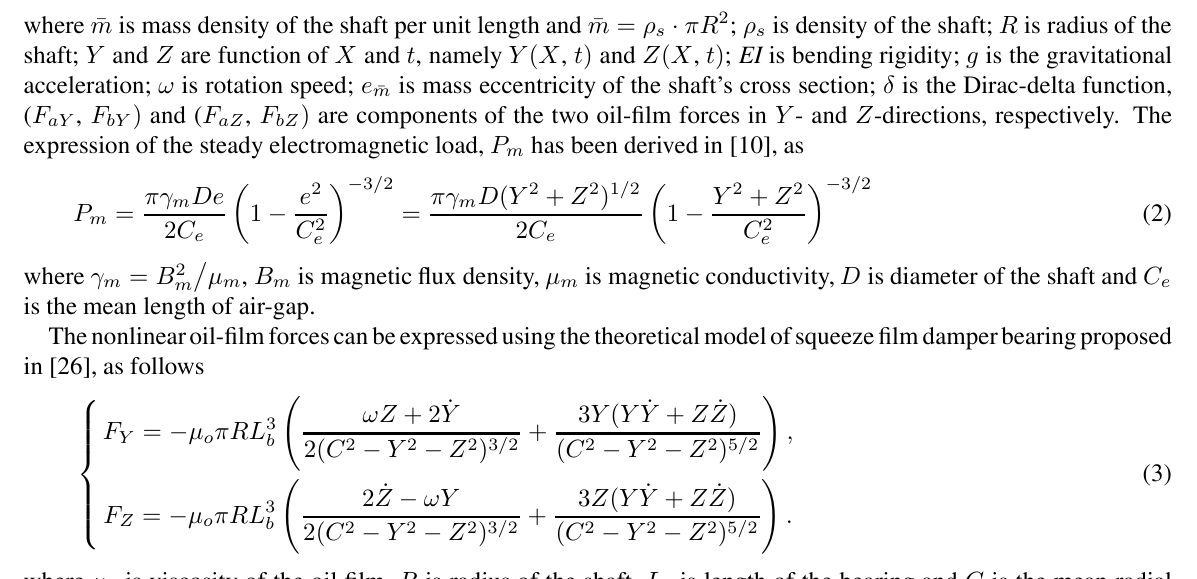
Fig. 2. The cross-section of the rotor